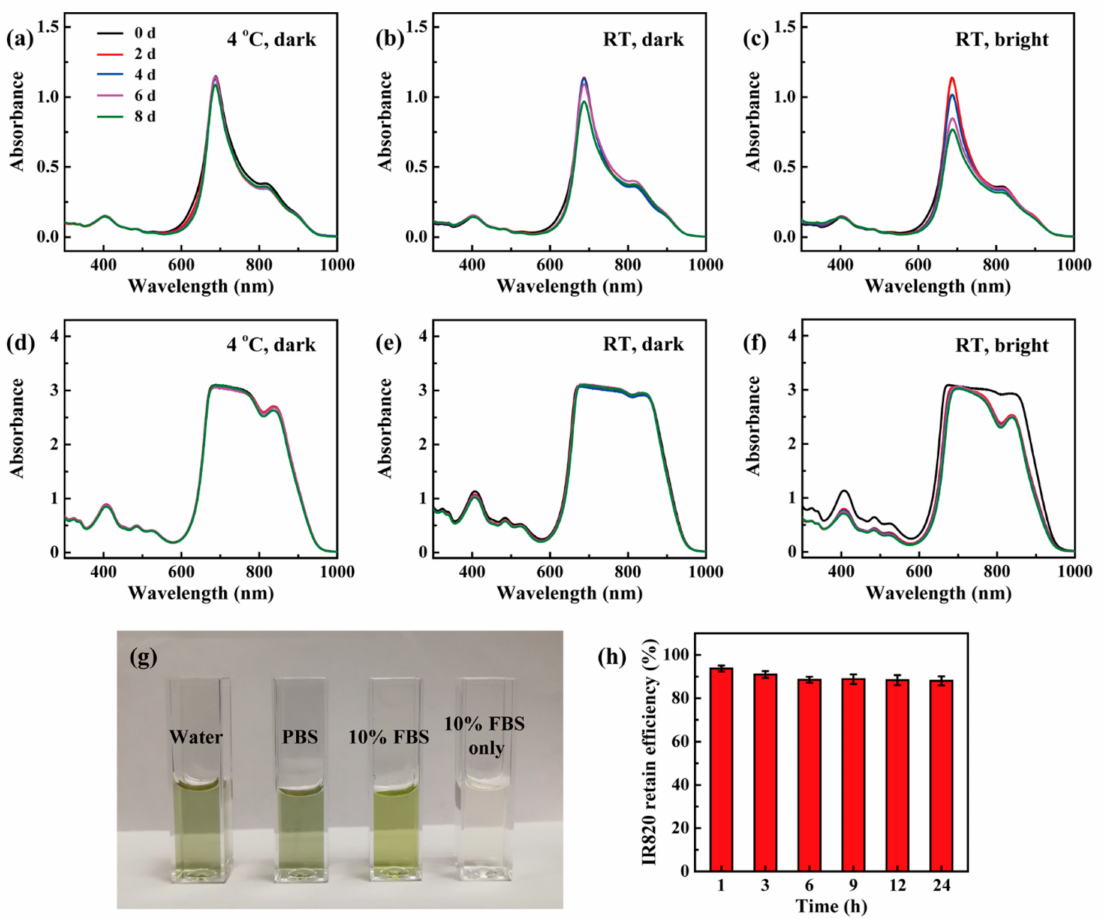
Figure 4. UV-vis spectra of free IR820 ( a – c ) and Ac-PR/IR820 ( d – f ) dendrimers when stored at distinct conditions; ( g ) the photo of Ac-PR/IR820 dendrimers dispersed in kinds of solvents; ( h ) the retain efficiency of Ac-PR dendrimers for